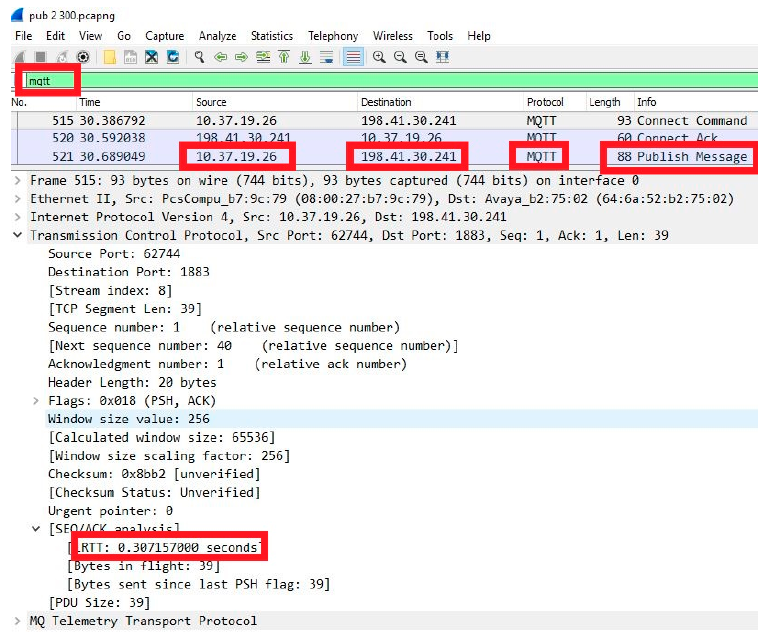
Figure 18. Communication delay implementation for case Ba.